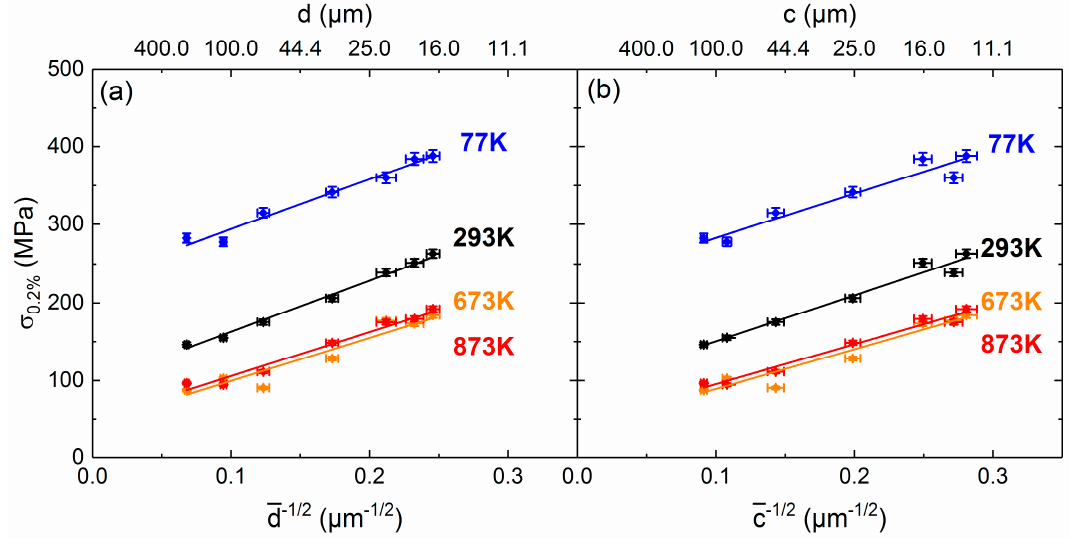
Figure 6. Hall–Petch plots at different temperatures. Yield stress ( σ 0.2% ) versus ( a ) reciprocal of the Figure 6. Hall – Petch plots at different temperatures. Yield stress ( σ 0.2 % ) versus ( a ) reciprocal of the square root of the grain size ( d ) and ( b ) crystallite size ( c ). square root of the grain size ( d ) and ( b ) crystallite size ( c ). Table 2. Hall – Petch parameters ( σ 0 and k y ) determined by fitting Equation (1) to the grain size ( d , upper part) and crystallite size ( c , lower part) data sets obtained at different temperatures.